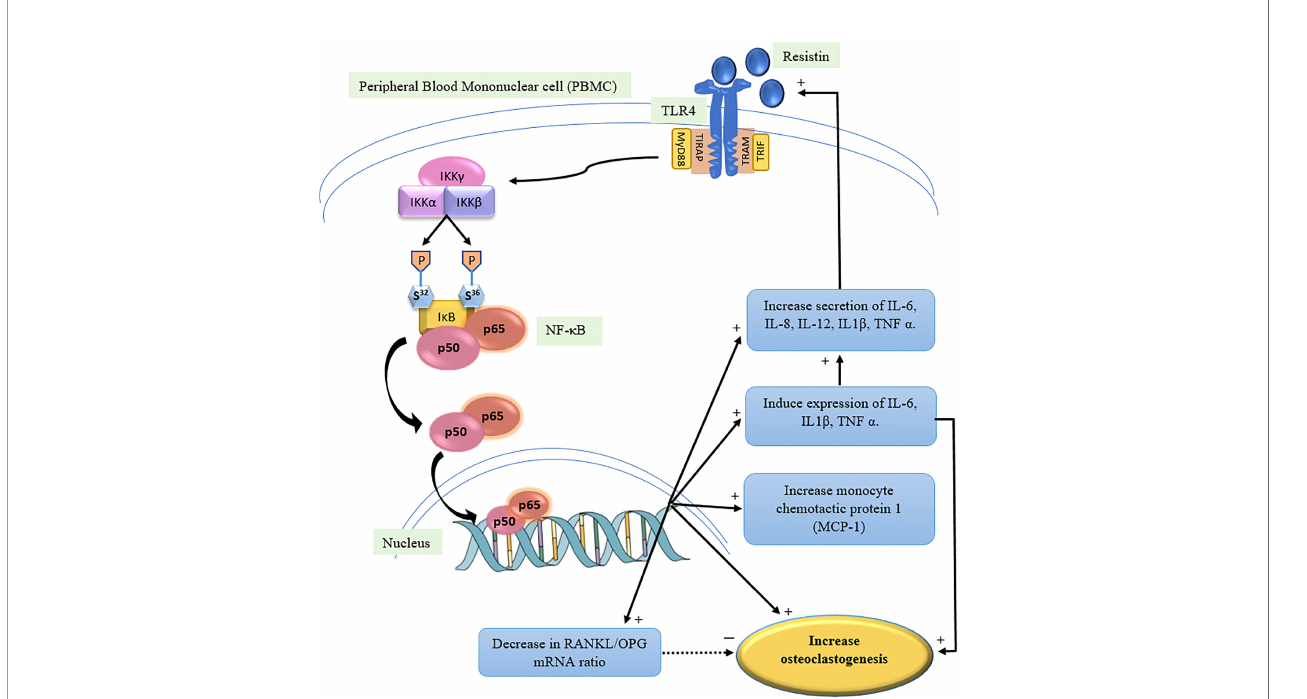
FIGURE 3 | Mechanism of action of Resistin to increase osteoclastogenesis (proposed) (1, 3, 12, 26). TLR4: Toll like receptor, MyD88: Myeloid differentiation primary response gene 88, TIRAP: Toll/interleukin-1 receptor domain containing adaptor protein, TRIF: TIR-domain-containing adaptor inducing interferon- b , TRAM: TRIF-related adaptor molecule, IKK: I k B kinase complex, NF- k B: Nuclear factor kappa light chain enhancer of activated B cells, RANKL: receptor antagonist of nuclear factor k B ligand, OPG: